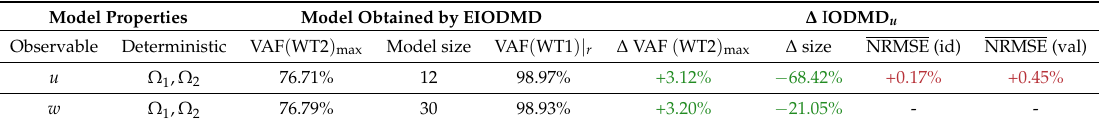
Table 5. Models validation results using the EIODMD algorithm with different base observables and deterministic